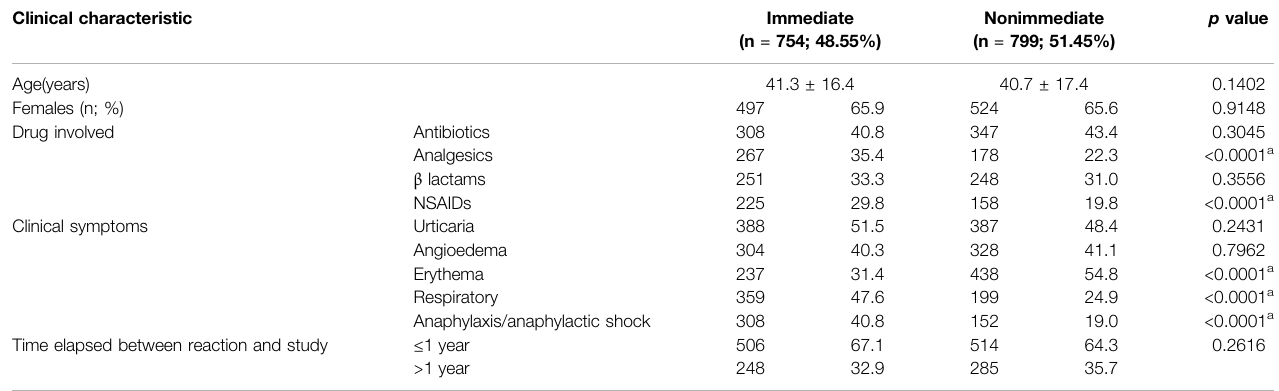
TABLE 3 | Clinical characteristics among all patients in regard to immediate and nonimmediate drug allergy reactions. Clinical characteristic